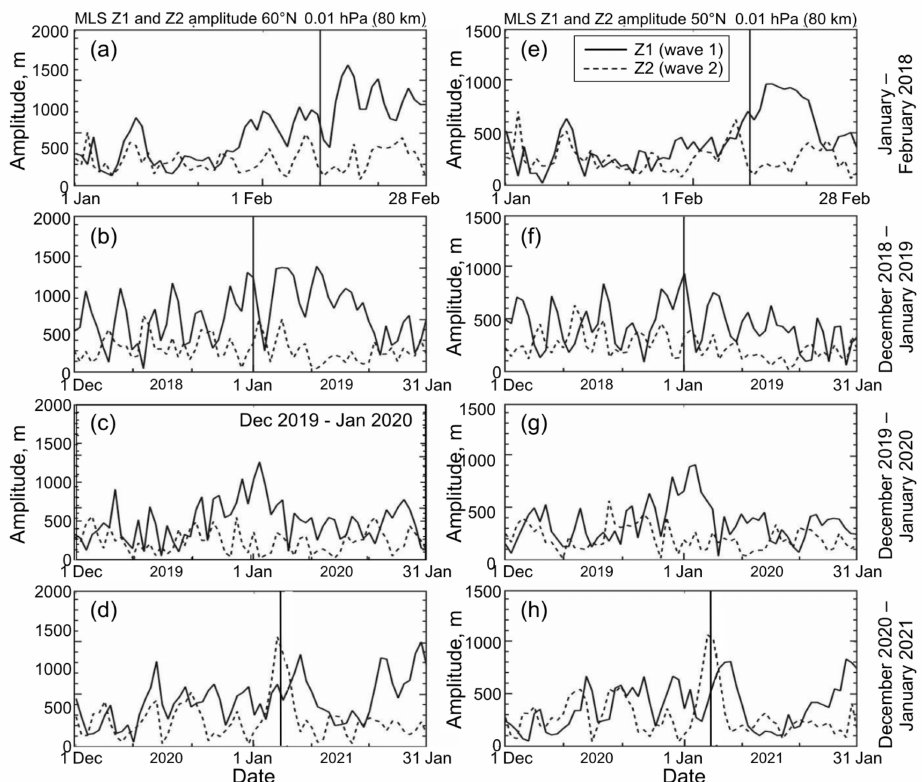
Figure 3. Amplitudes of zonal wave 1 (Z1; solid line) and wave 2 (Z2; dashed line) in geopotential height at 0.01 hPa (80 km), at ( a – d ) 60 ◦ N and ( e – h ) 50 ◦ N from the MLS data. Four boreal winters of 2018–2021 are presented. Vertical lines indicate the SSW onset